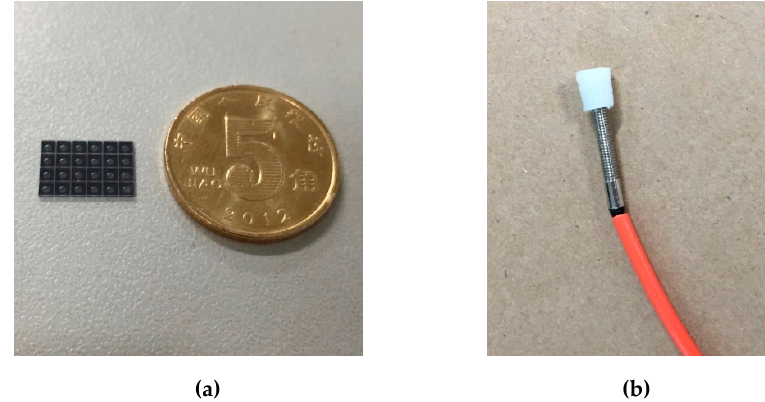
Figure 6. Images of ( a ) the pressure-sensitive probes and ( b ) the hybrid fiber-optic F–P sensor.